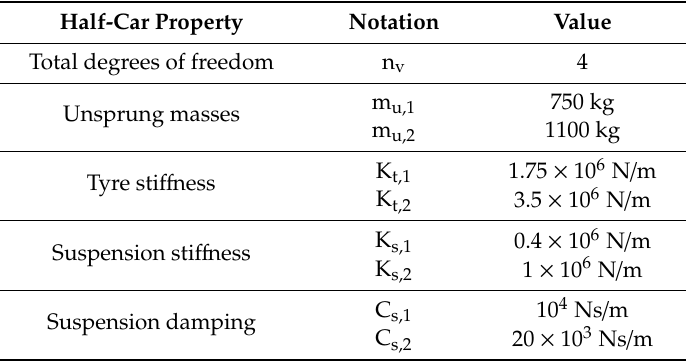
Figure 1. Section of a half-car vehicle model with general road profile on the bridge. Table 3. Properties of the half-car model.